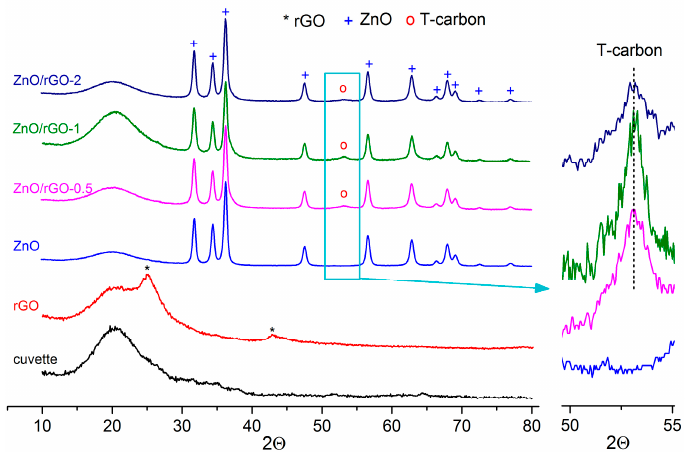
Figure 1. XRD pa tt erns of rGO, ZnO, and ZnO/rGO nanocomposites with di ff erent rGO content.